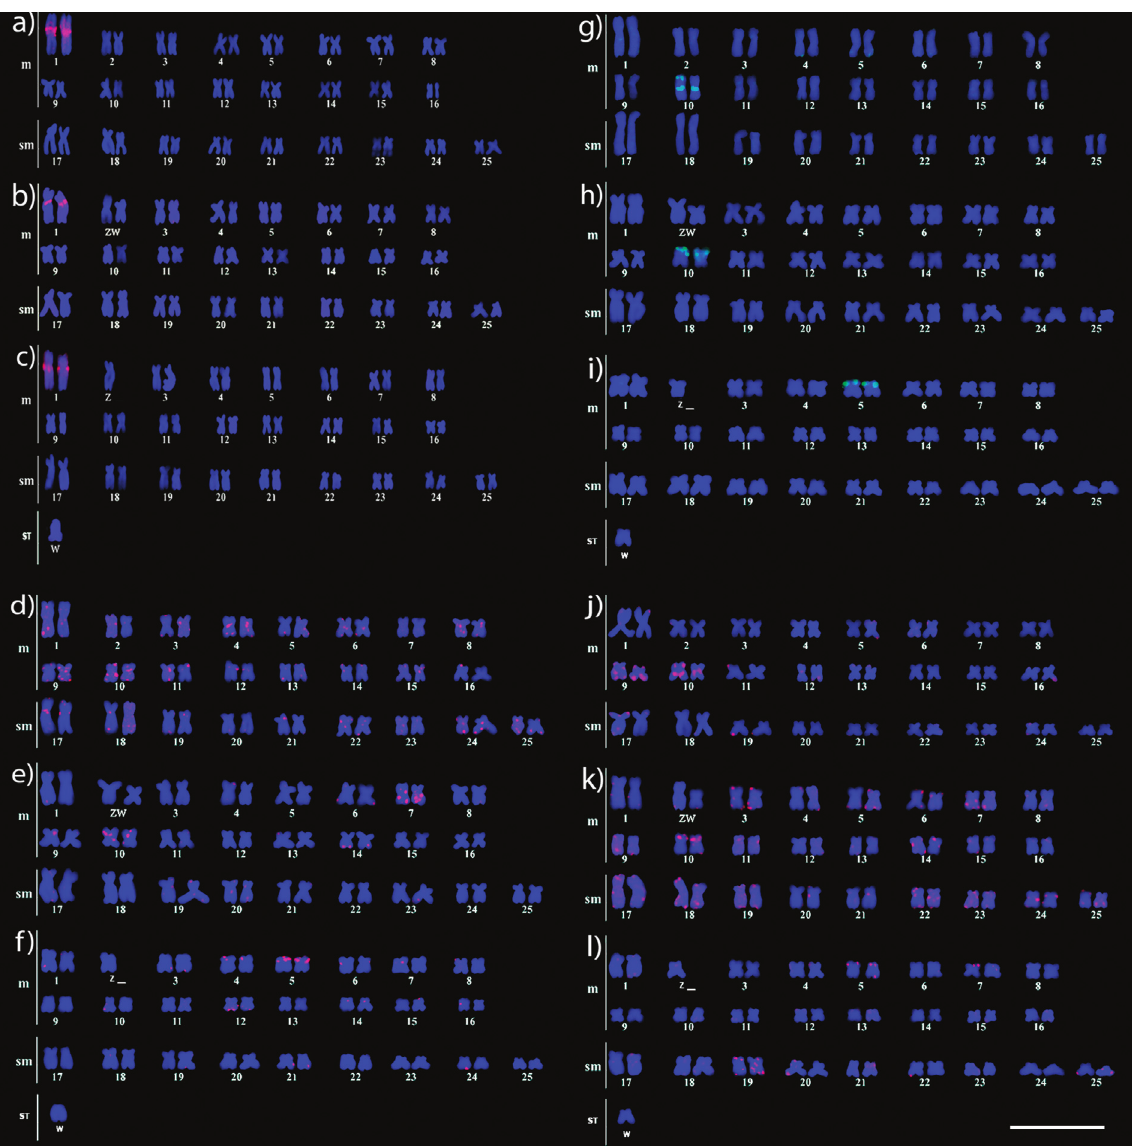
Figure 3 - Karyotypes of Characidium females subjected to fluorescence in situ hybridization (FISH) with multigene family probes. (a) C. zebra , (b) C. gomesi (PG), (c) C. gomesi (SJ); H1 (d) C. zebra , (e) C. gomesi (PG), (f) C. gomesi (SJ); (g) C. zebra , (h) C. gomesi (PG), (i) C. gomesi (SJ); (j) C. zebra , (k) C. gomesi (PG), (l) C. gomesi (SJ). PG, Paiol Grande Stream population; SJ, São João River population. Scale bar, 10 (cid:2)